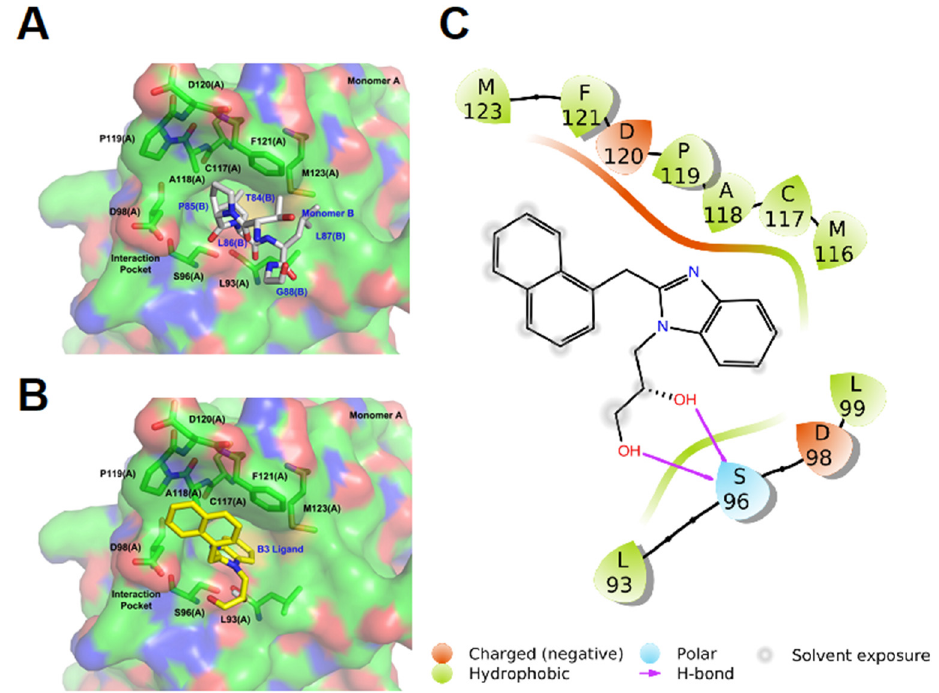
Figure 9. Analysis of the theoretical binding mode of B3 to ppUL44. A graphic representation of ppUL44(1-290) dimerization pocket is shown in the absence ( A ) or in the presence ( B ) of B3. One monomer is represented as surface, with residues involved in dimerization represented as green (Monomer A), or gray sticks (Monomer B), whereas B3 is shown as yellow sticks. ( C ) The 2D ligand interaction diagram of the theoretical binding mode for B3 is shown. Hydrogen bond interactions are shown as violet arrows. Positive and negative charged amino acids are represented in blue and red, respectively. Residues involved in hydrophobic or polar interactions are shown in green and light blue, respectively. Ligand-exposed fractions are indicated as a gray, circular shadow.